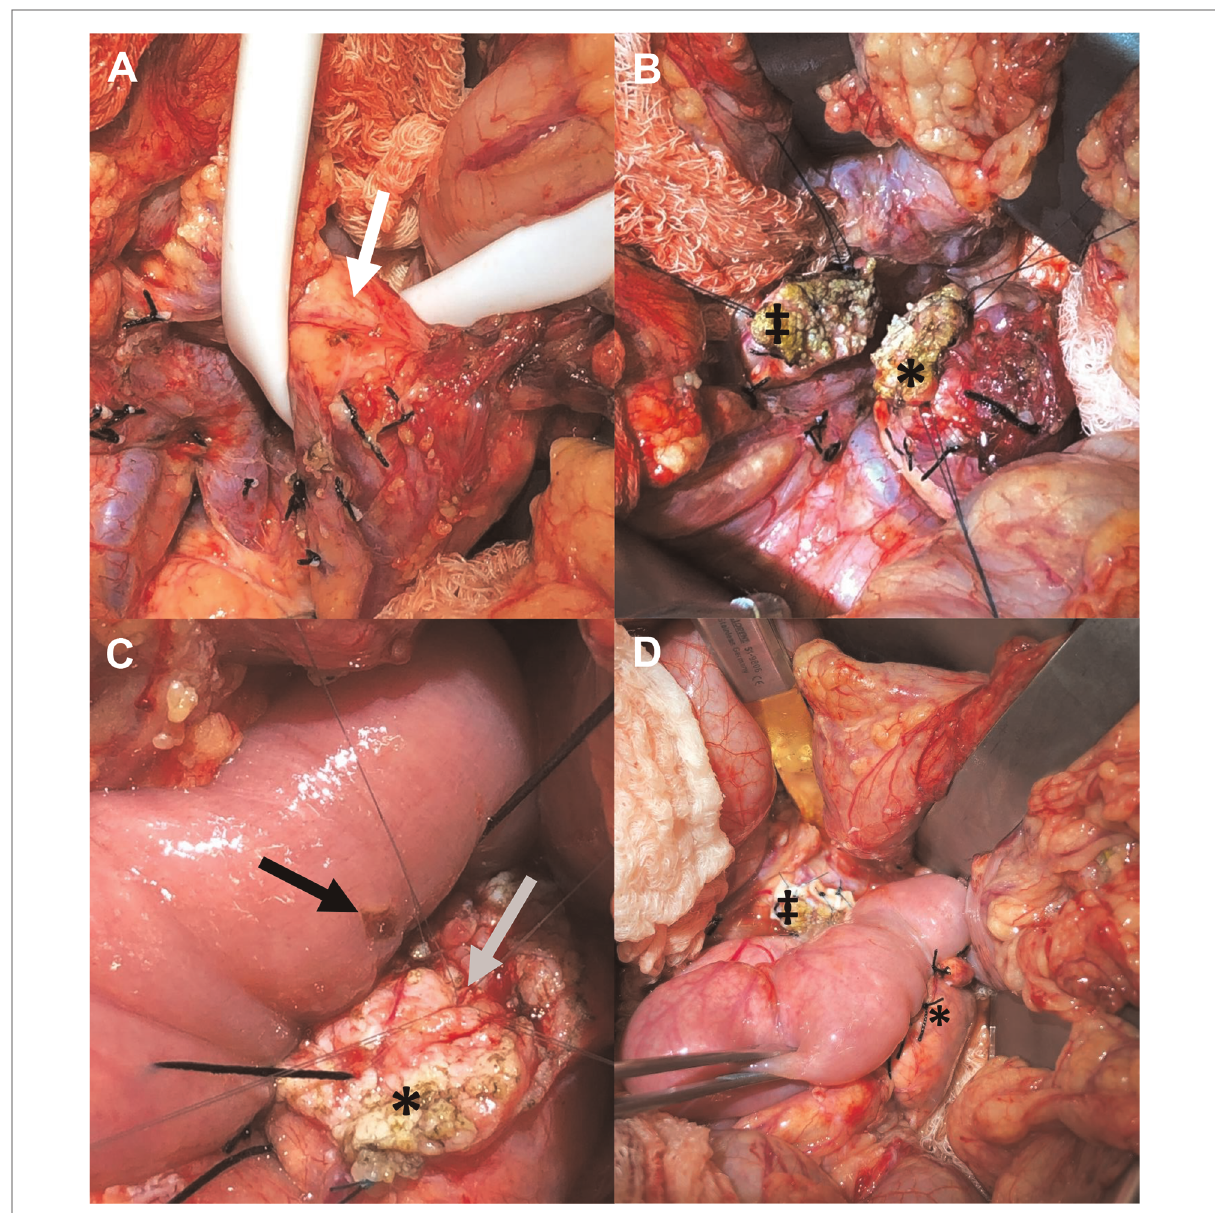
FIGURE 13 Central pancreatectomy. ( A ) Ewing sarcoma is demonstrated within the neck of the pancreatic parenchyma (white arrow). ( B ) Following resection of the neck of pancreas with mass, edges of the transected pancreatic head ( ‡ ) and body (*) are demonstrated. ( C ) For reconstruction, a Roux-en-Y jejunal enterotomy is made (black arrow), and the main pancreatic duct (gray arrow) within the distal pancreatic remnant (*) is prepared for anastomosis. ( D ) Reconstruction involving anastomosis of the Roux-en-Y jejunal limb to the distal pancreatic remnant (*) creating a complete pancreaticojejunal anastomosis. The remnant pancreatic head is also demonstrated ( ‡ ). IMV: inferior mesenteric vein; PV: portal vein; SMA: superior mesenteric artery; SMV, superior mesenteric